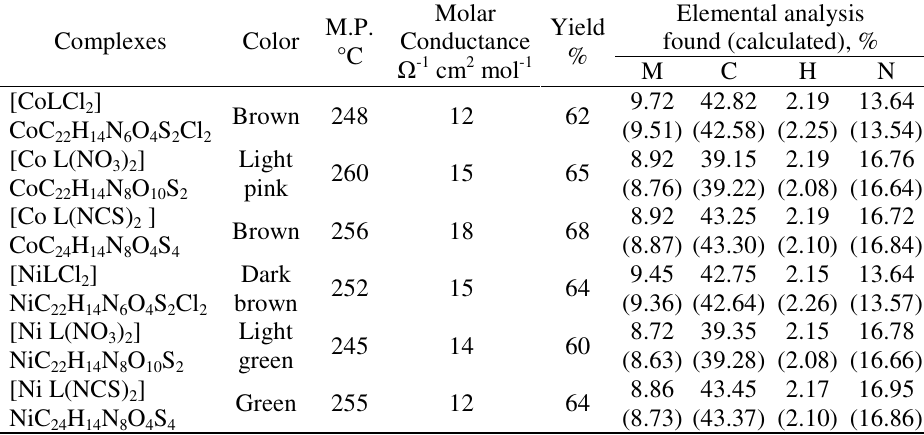
Table1 . Physical properties and analytical data of complexes